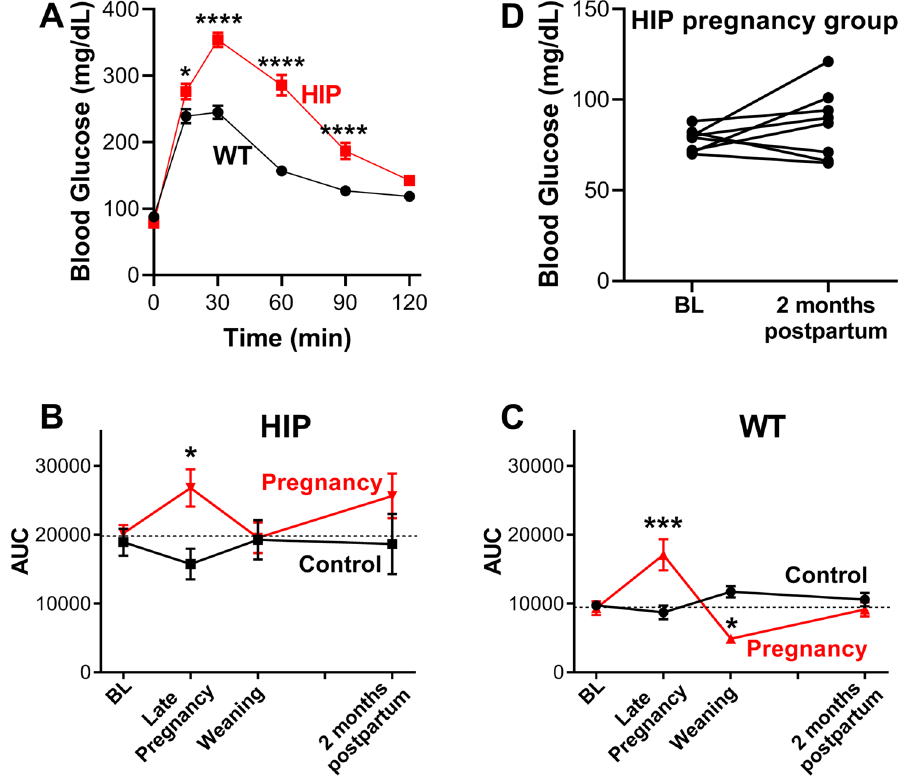
Figure 1. HIP females as a model of gestational diabetes. ( A ) HIP females (5–6 months of age) have reduced glucose tolerance compared to WT littermates, but fasting blood glucose is similar (n = 25 for WT, 30 for HIP). ( B,C ) Area under the curve in glucose tolerance tests performed in HIP ( B ) and WT ( C ) females in the pregnancy (N = 17 HIP and 14 WT in total) and control (N = 13 HIP and 11 WT in total) groups at baseline (BL), late (19–20 days) pregnancy, at the time of weaning the pups and 2 months postpartum. ( D ) Fasting blood glucose in HIP females from the pregnancy group at baseline and 2 months postpartum (N = 8). Statistical analysis was performed using Two-way ANOVA with Bonferroni’s multiple comparisons post-test for data in panels A-C and paired Student’s t-test for data in panel D.